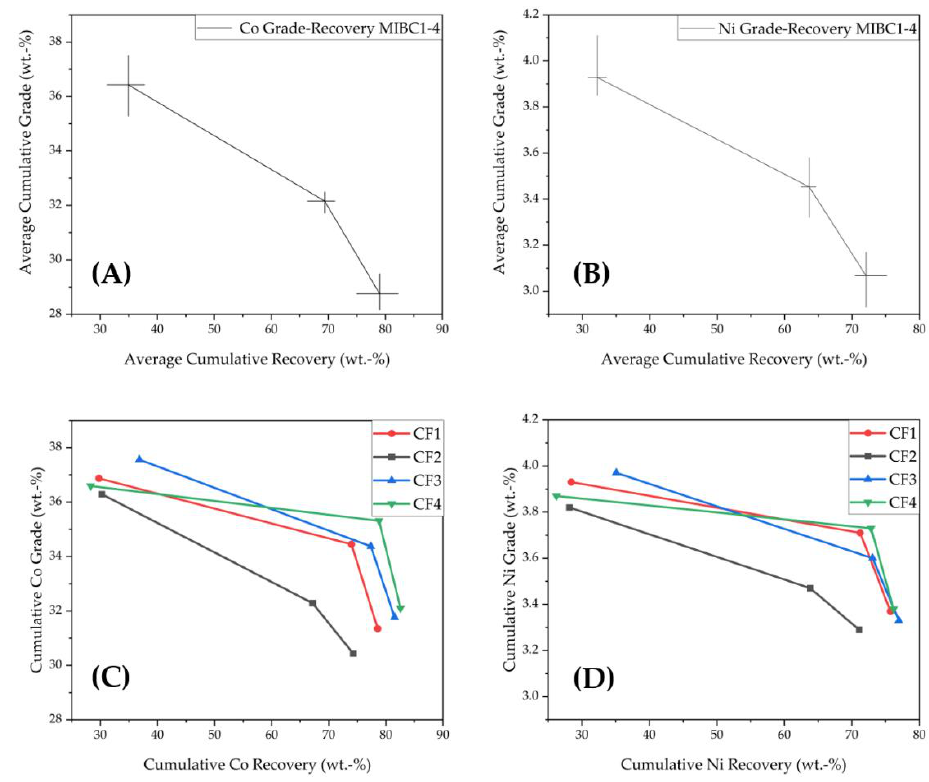
Figure 4. Grade–recovery curves for specific elements in the flotation experiments. ( A ) Co in the MIBC experiments. ( B ) Ni in the MIBC experiments. ( C ) Co in the CellFroth experiments. ( D ) Ni in the CellFroth experiments.